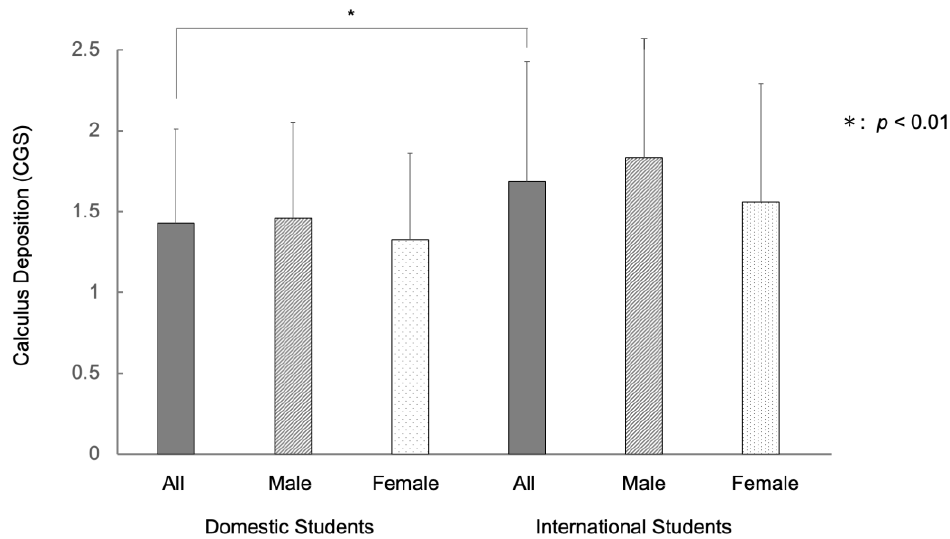
Figure 3. Differences of calculus deposition between international and domestic university students in Japan. Note: The mean CGS of international students ( n = 79) was 1.68 and that of domestic students ( n = 152) was 1.43. The international students showed more extensive calculus deposition ( p < 0.01). Error bars denote the standard deviations of the data.